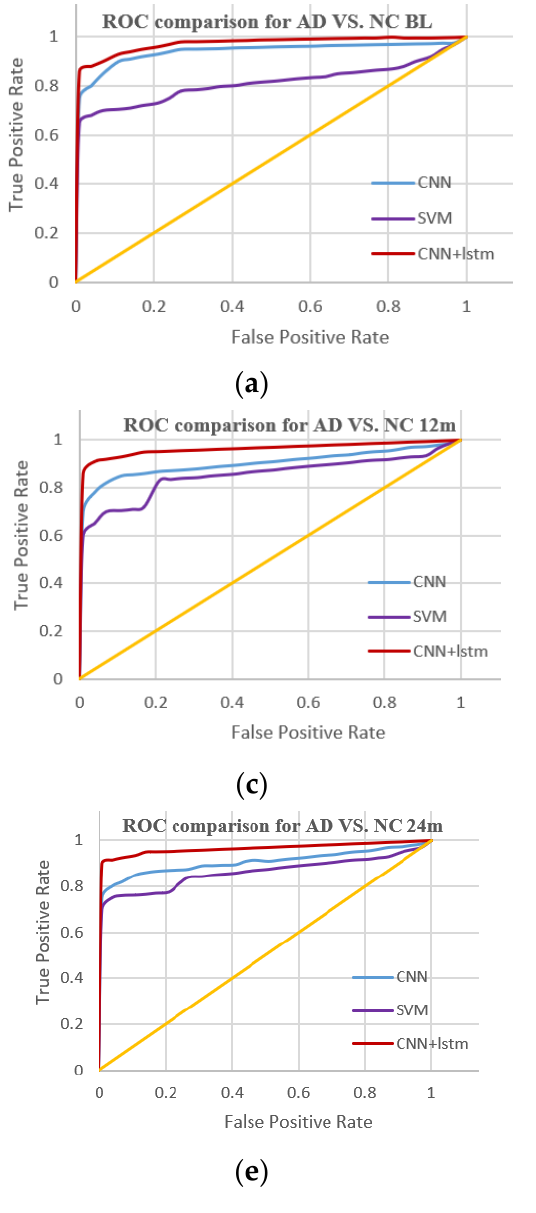
Figure 13. Comparison of the ROC curves of different algorithms; ( a ) comparison of the ROC curves of different algorithms for NC vs. AD at BL; ( b ) comparison of the ROC curves of different algorithms for sMCI vs. pMCI at BL; ( c ) comparison of the ROC curves of different algorithms for NC vs. AD at 12 m; ( d ) comparison of the ROC curves of different algorithms for sMCI vs. pMCI at 12 m; ( e ) comparison of the ROC curves of different algorithms for NC vs. AD at 24 m; and ( f ) comparison of the ROC curves of different algorithms for sMCI vs. pMCI at 24